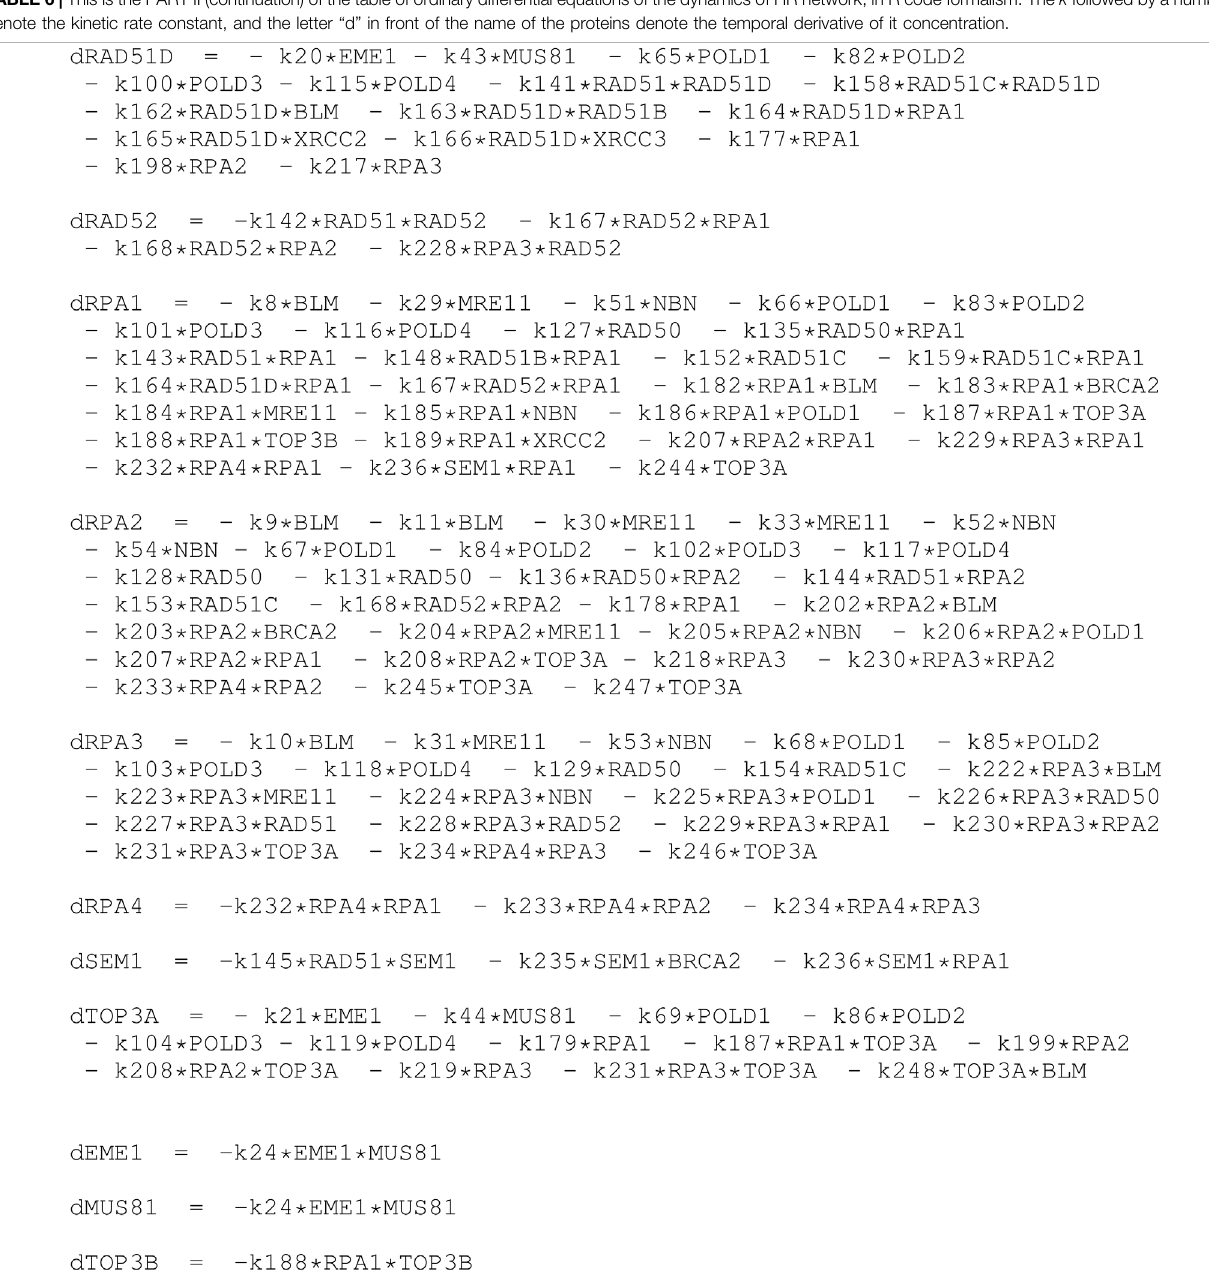
Frontiers in Molecular Biosciences |